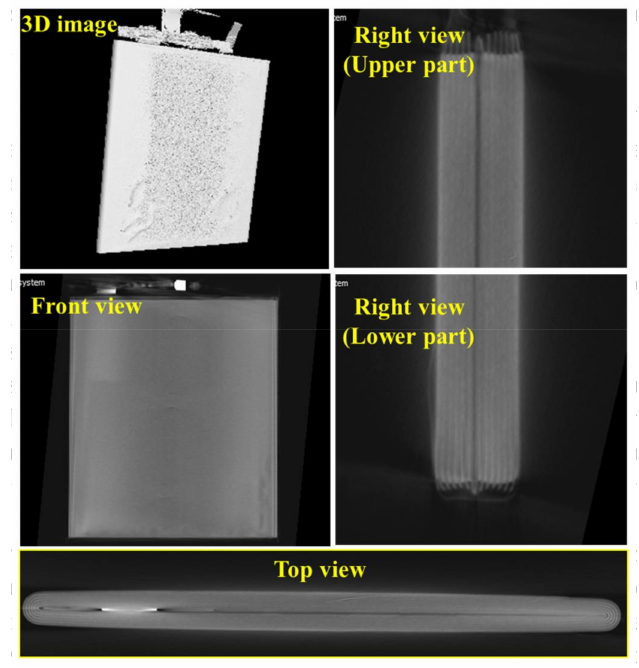
Figure 23. CT scan images of the battery from the new smartphone sample.